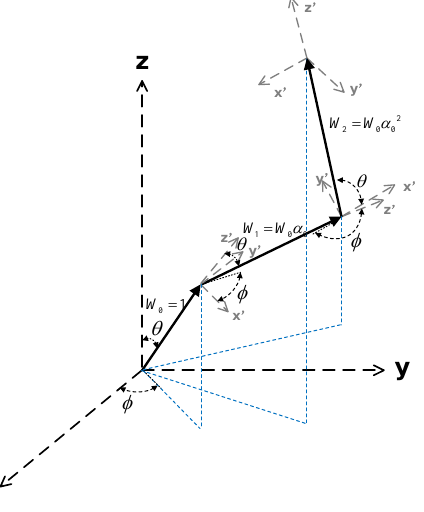
Figure 3. Multiple scattering path of each photon.